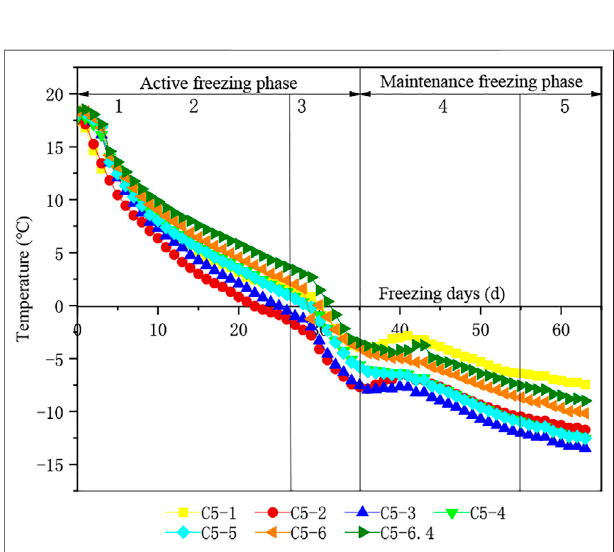
FIGURE 10 | Correlation between the temperature in temperature hole C3 and time.